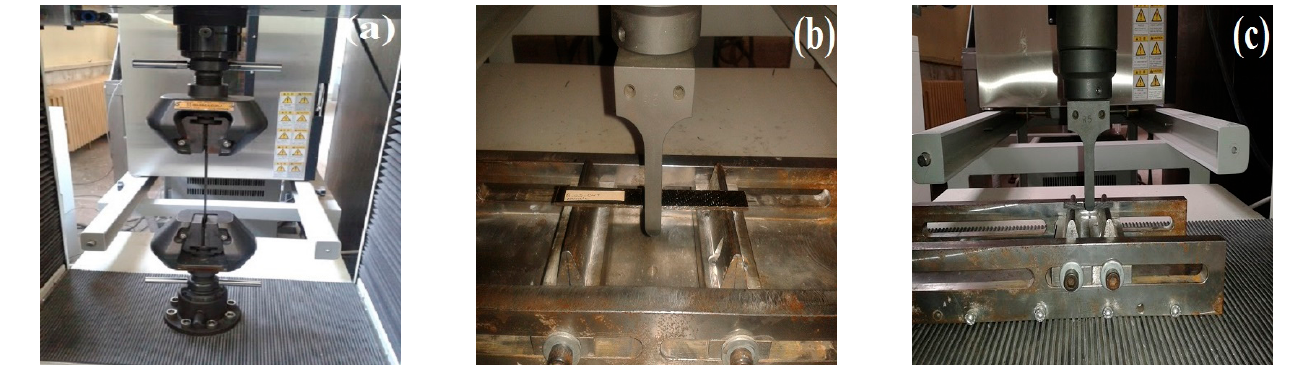
Figure 5. Mechanical tests of fabricated composites: ( a ) tensile test, ( b ) bending test and ( c ) inter-laminar shear strength (ILSS) test.